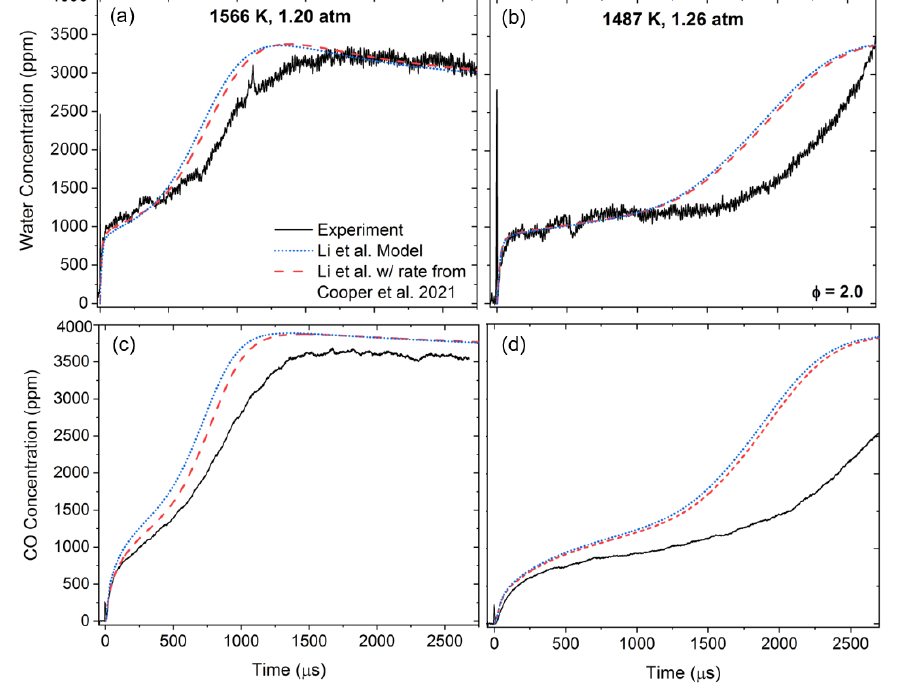
Figure 10. Comparison of predictions made by the Li et al. model and those made by the Li et al. model using the reaction rate presented by Cooper et al. [21] for reaction (1). Profiles ( a , c ) were taken simultaneously in an experiment at 1566 K and 1.20 atm, and ( b , d ) were taken at 1487 K and 1.26 atm. Both experiments were conducted with the φ = 2.0 mixture.